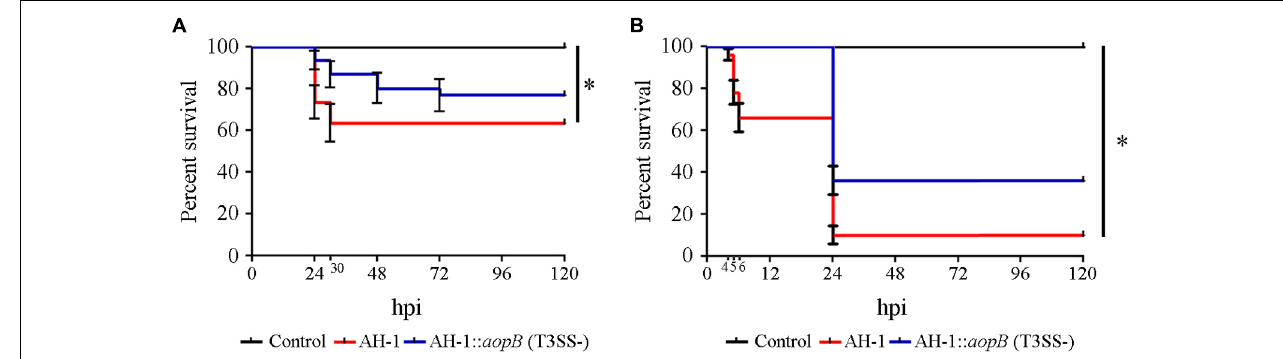
FIGURE 1 | Implications of the T3SS in the pathogenesis of Aeromonas hydrophila . (A) Kaplan–Meier survival curve of healthy larvae after infection with bacterial suspensions. ∗ Significant differences at P < 0.005. (B) Kaplan–Meier survival curve of injured larvae after infection with bacterial suspensions. ∗ Significant differences at P < 0.0001. In all cases, the graphs show representative results of five independent experimental infections conducted using four biological replicates of ten larvae each. Healthy and injured larvae were infected with a bacterial suspension (AH-1 wild-type or AH-1:: aopB ) containing 2 × 10 7 CFUs · mL − 1 and 5 × 10 7 CFUs · mL − 1 , respectively.